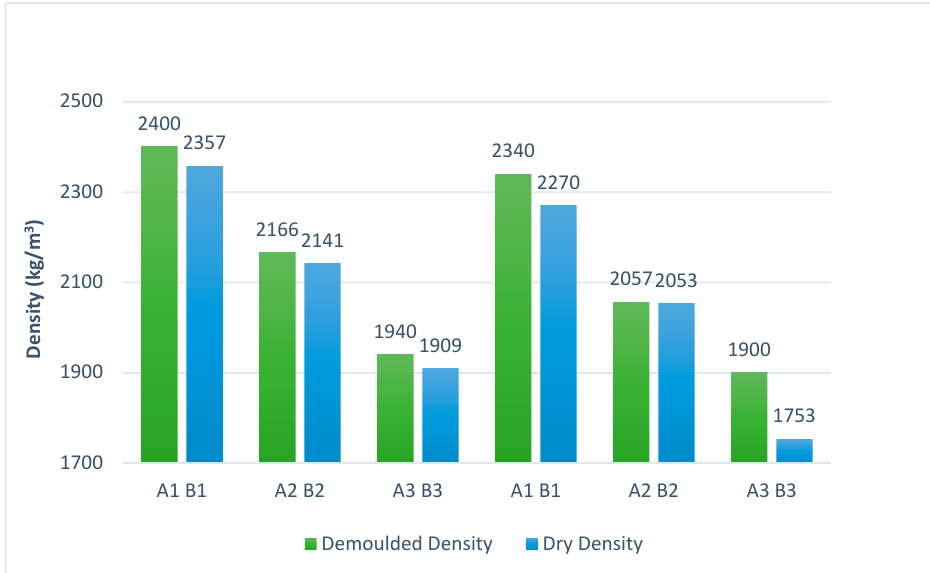
Figure 6. Demolded and dry density of specimens.